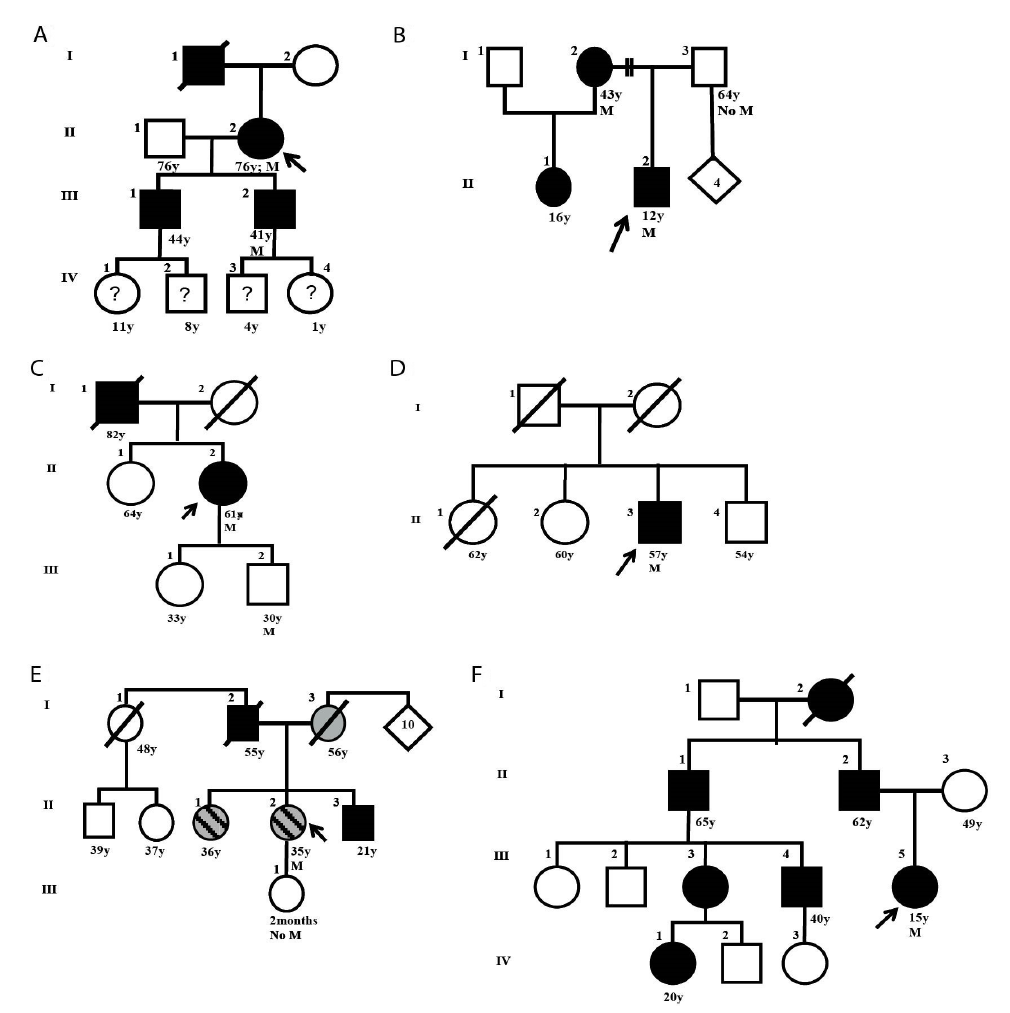
Figure 2. Genealogy tree of families with nevoid basal cell carcinoma syndrome (NBCCS) and known germline mutation: ( A ) SG6 family, ( B ) SG7 family, ( C ) SG12 family, ( D ) SG13 family, ( E ) SG20 family, and ( F ) SG21 family. The black arrows indicate the studied proband. Symbols filled in black indicate affected members with clinical manifestations. Symbols with “?” indicate that no clinical diagnosis was made. Symbols filled in grey indicates the family member affected by Autosomal Dominant Polycystic Kidney Disease (ADPKD) whereas the stripped ones indicate the family members affected by NBCCS and ADPKD. M: Mutation found in PTCH1 ; No M: No mutation in PTCH1